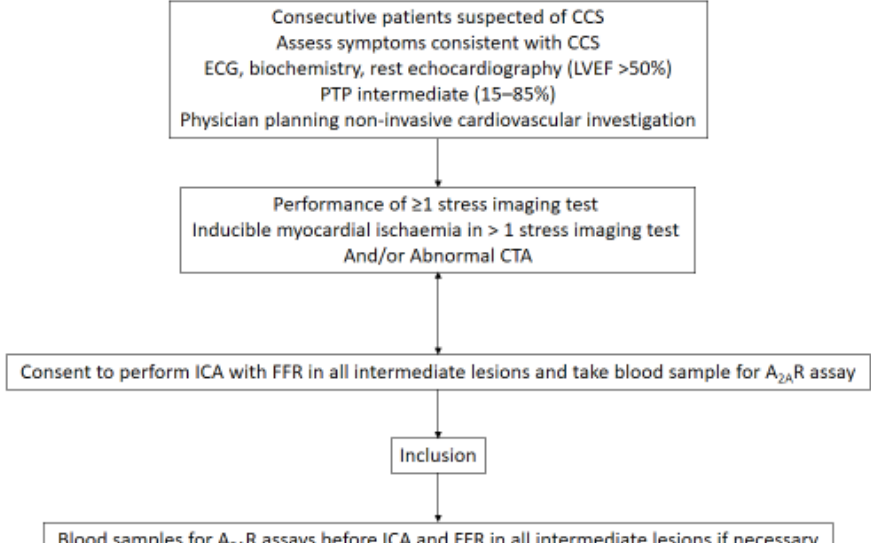
Figure 1. Flowchart methods. Patients with positive imaging stress, abnormal computed tomography angiography (CTA), or both were included. CCS: suspected coronary syndrome. PTP: pretest probability.